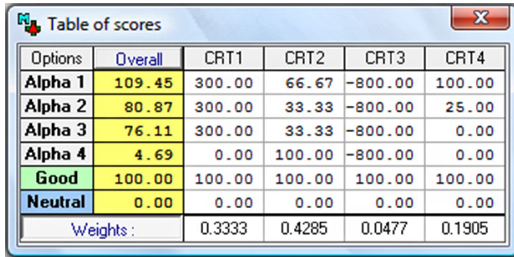
Table 4. Partial values and overall attractiveness revealed by the